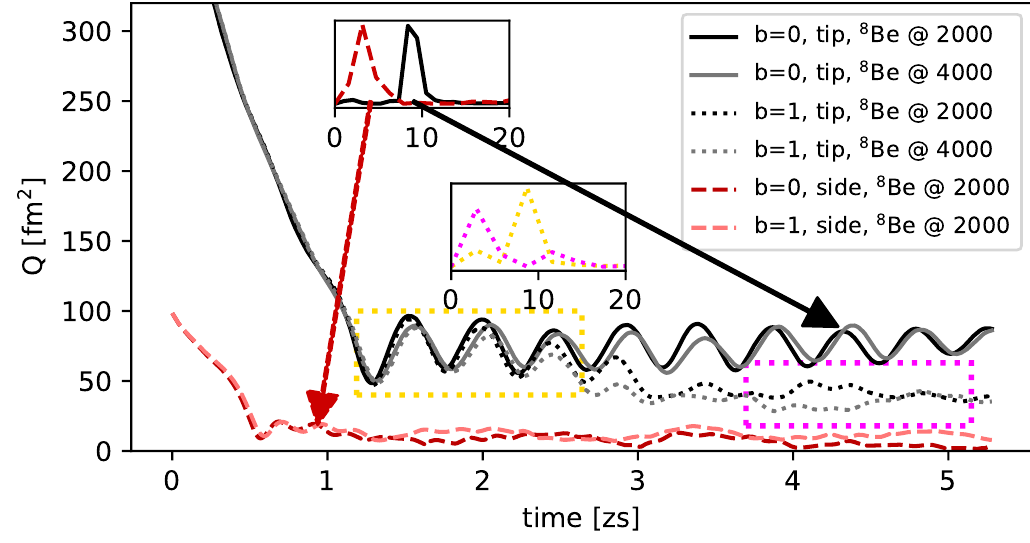
Figure 2: Quadrupole moment of the matter density during collisions of 4 He with compound 8 Be ∗ nucleus with initial conditions as per the legend and discussed in the text. The two insets show the Fourier power spectrum of parts of the quadrupole moment: The upper inset panel shows the spectrum of the resonance created in a tip collision (solid black) and a side collision (dashed red) both at b = 0 and using the 2000 configuration of 8 Be ∗ . The lower panel shows two spectra from the b = 1 tip 2000 configuration with the yellow (lighter) dotted line from the time signal as shown in the yellow (lighter) dotted box, and the pink (darker) dotted line showing the spectrum from the later time signal in the pink (darker) dotted